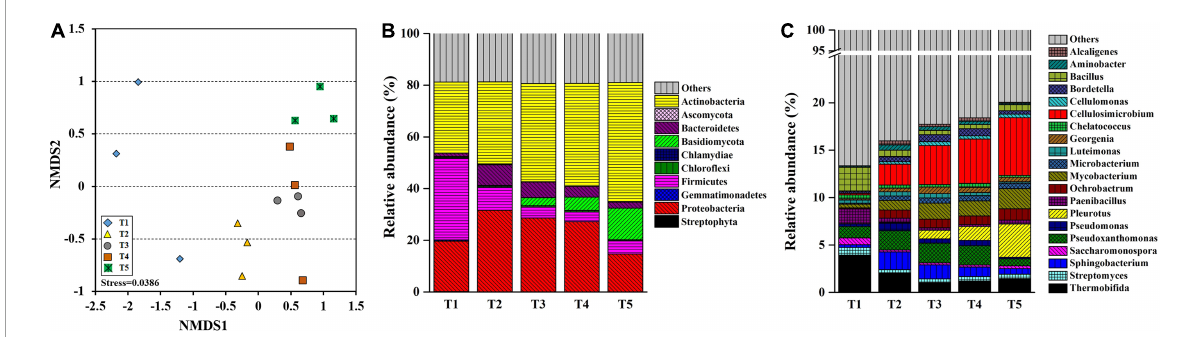
FIGURE3 Bray-Curtis-based non-metric multidimensional scaling (NMDS) analysis (A) and taxonomic structure of the bacterial community at the phylum (B) and genus (C) levels in composting substrate at the different growth stages of oyster mushroom. T1, T2, T3, T4, and T5 indicate the day on which composting was completed (day 0: before spawning), mycelial colonization (day 3), mid-incubation (day 10), end-incubation (day 20: before primordia formation), and first oyster mushroom fructification (day 30: fruiting body development), respectively.